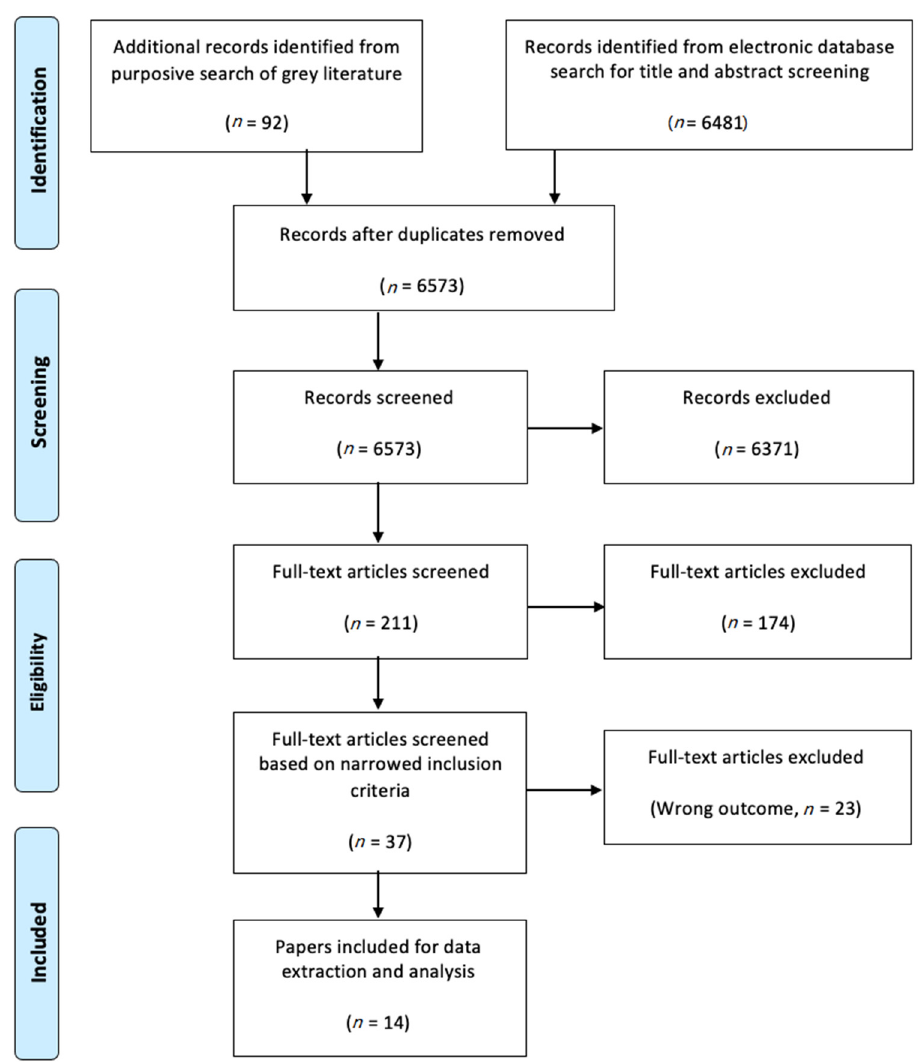
Figure 2. Flowchart of CDW prevalence study selection.